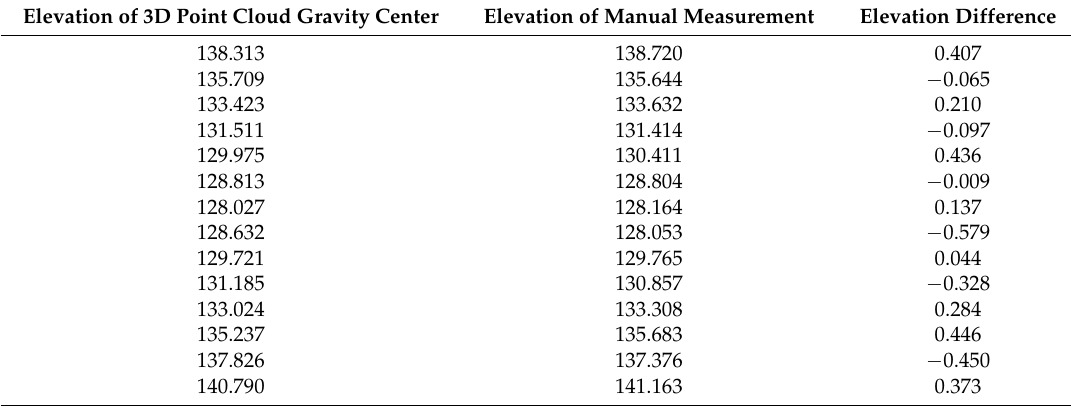
Table 2. Distribution of Elevation Difference of Sampling Points in the Power Line Profile (Unit: m). Elevation of 3D Point Cloud Gravity Center